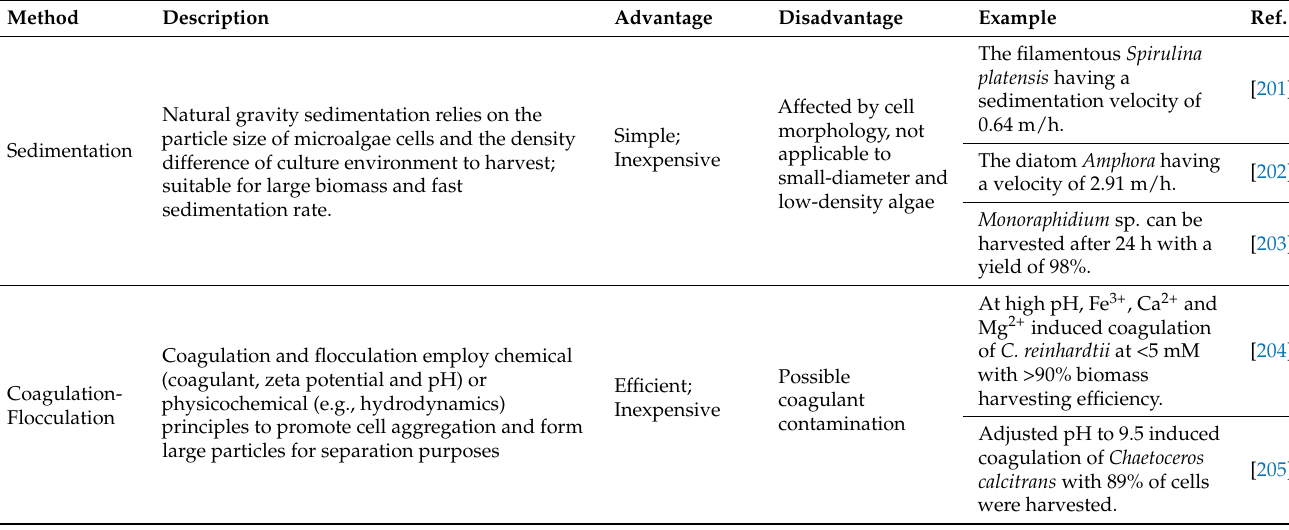
Table 2. Harvesting method of microalgae